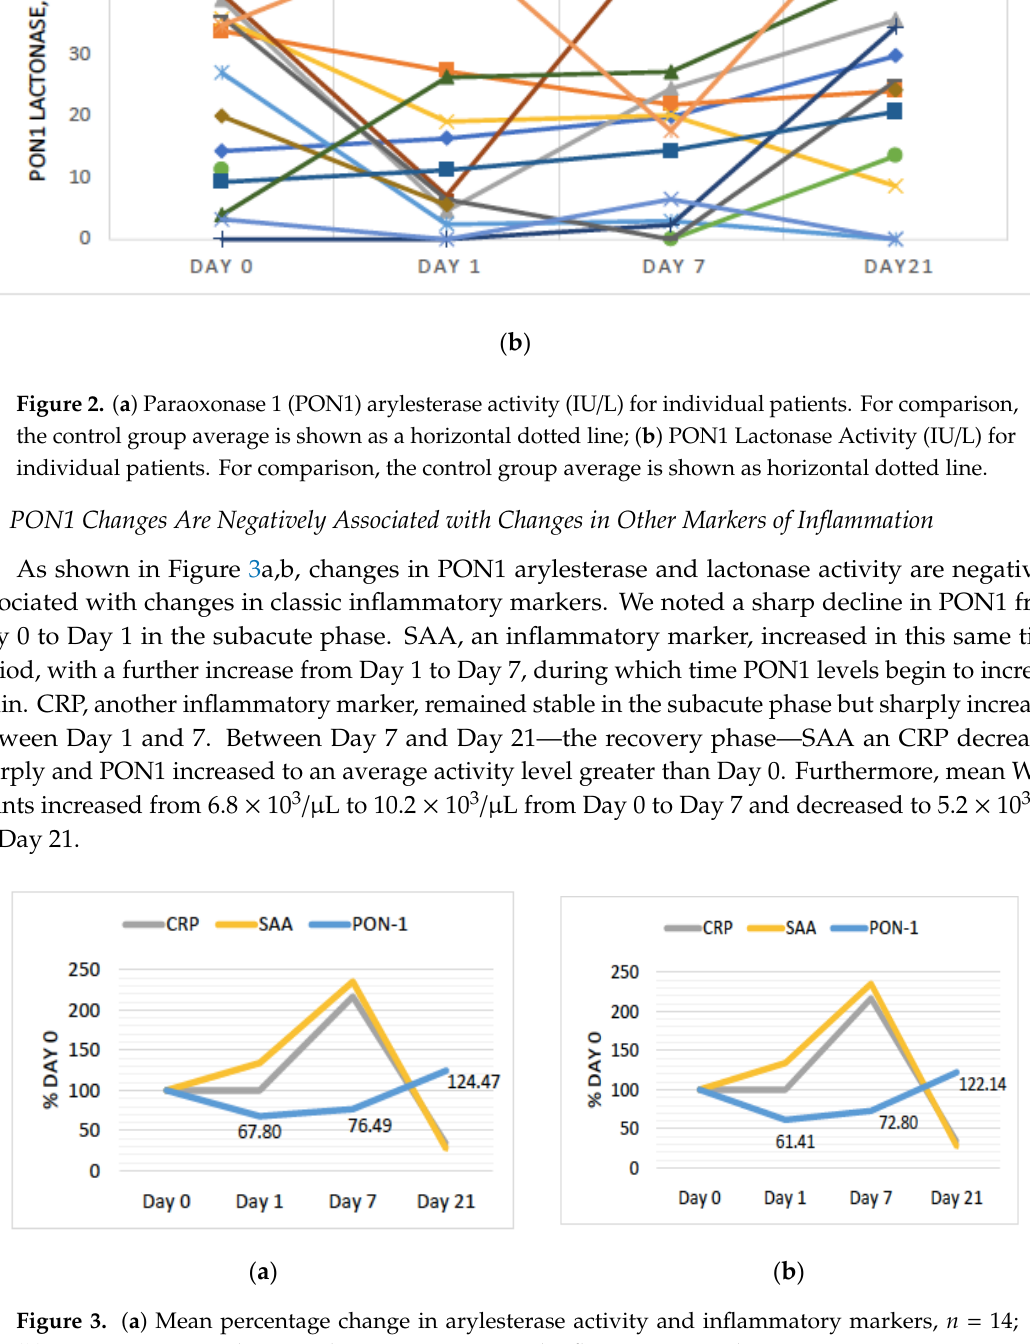
Figure 3. (a) Mean percentage change in arylesterase activity and inflammatory markers, n = 14 ; (b) mean percentage change in lactonase activity and inflammatory markers, n = 14. CRP: c-reactive protein; SAA: serum amyloid A.